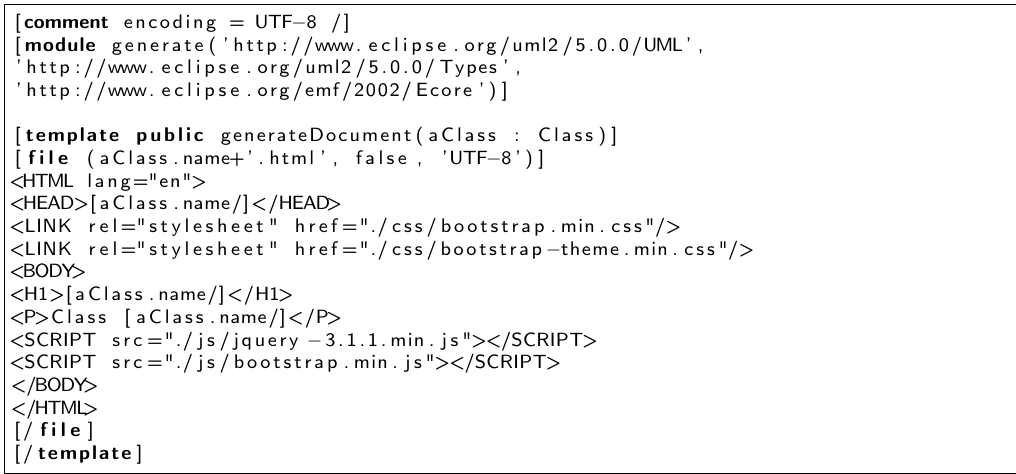
Figure 1. The excerpt of the ACCELEO code that generates XHTML documents from UML class diagram models.